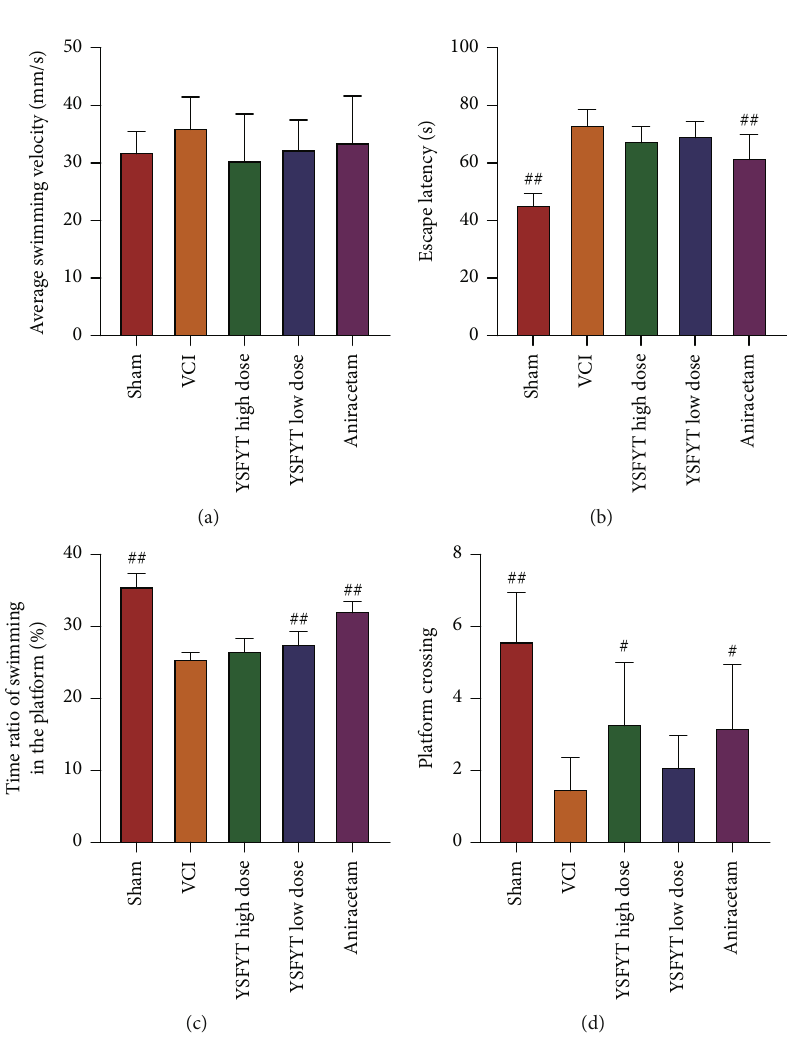
Figure 2: Morris water maze results. (a) Average swimming velocity. (b) Escape latency. (c) Ratio of swimming time in plateau period. (d) Four indicators of the number of crossing platforms. # p < 0 : 05 ; ## p < 0 : 01